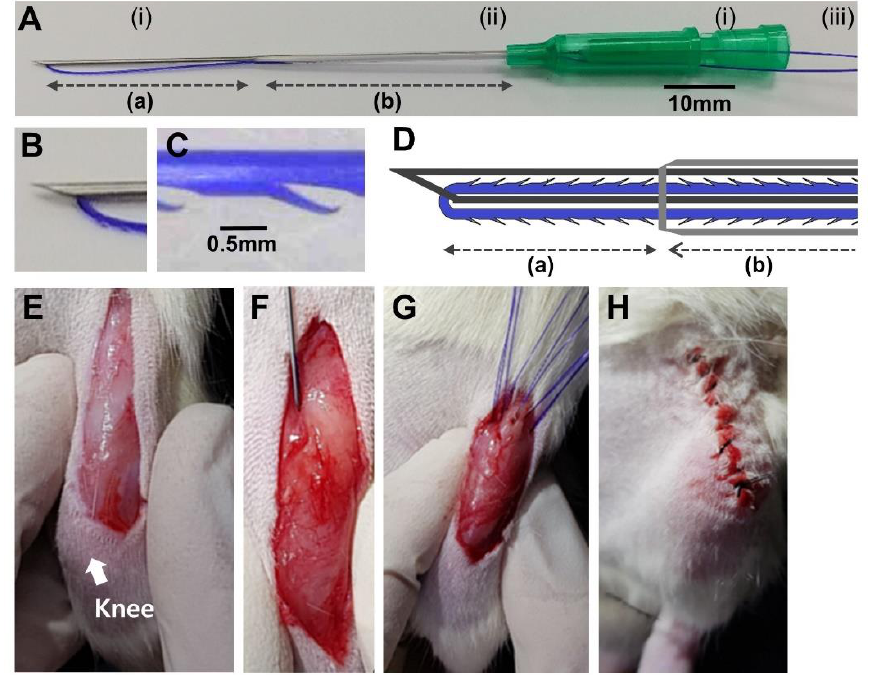
Figure 1. Application of MEST. MEST consists of (i) needle with handle, (ii) catheter with handle, (iii) PDO filament ( A ). The PDO filament equipped bi-directional cogs for effective muscle holding ( B – D ). The cogs in the forward direction (a) of needle insertion were exposed whereas cogs in the reverse direction (b) were protected by the catheter during needle insertion ( D ). After administration, the remaining filaments outside of the skin ( G ) were cut and removed. MEST was performed in rats similar to the purpose of clinical use, except that skin incision and closure were included under respiratory anesthesia. In addition, the needle was only partially inserted for rats due to the small size of the muscles ( E – H ).